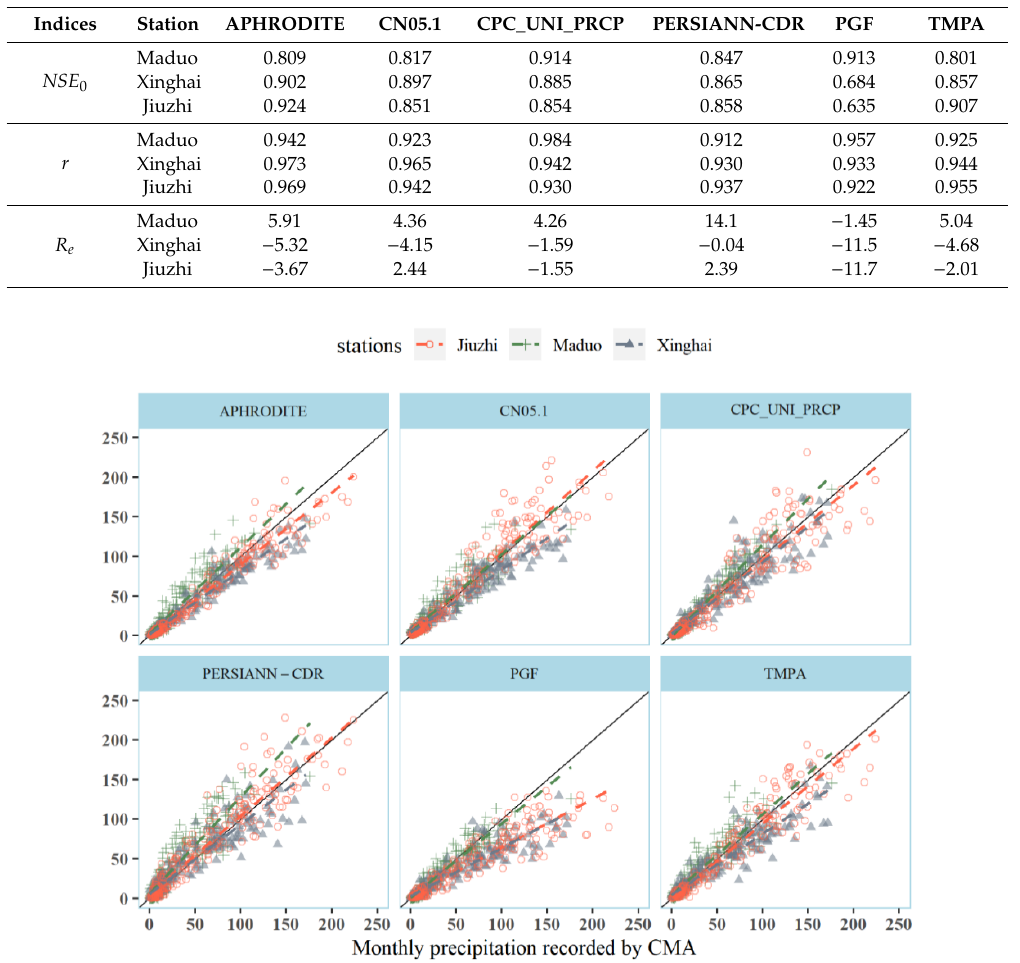
Table 6. Correlation coe ffi cients ( r ), NSE 0 , and relative errors ( R e , unit: %) between precipitation products and gauged-based observations at 3 meteorological stations at a monthly scale.